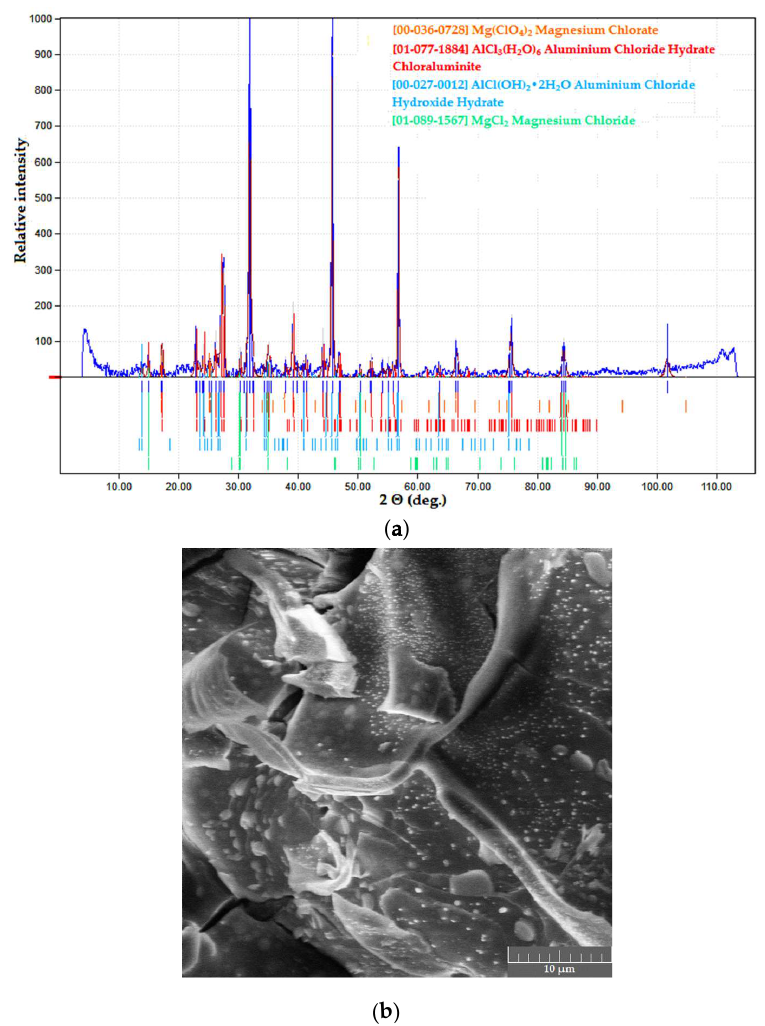
Figure 8. Dried products in the Na-CMC–MAY system: ( a ) phase composition; ( b )